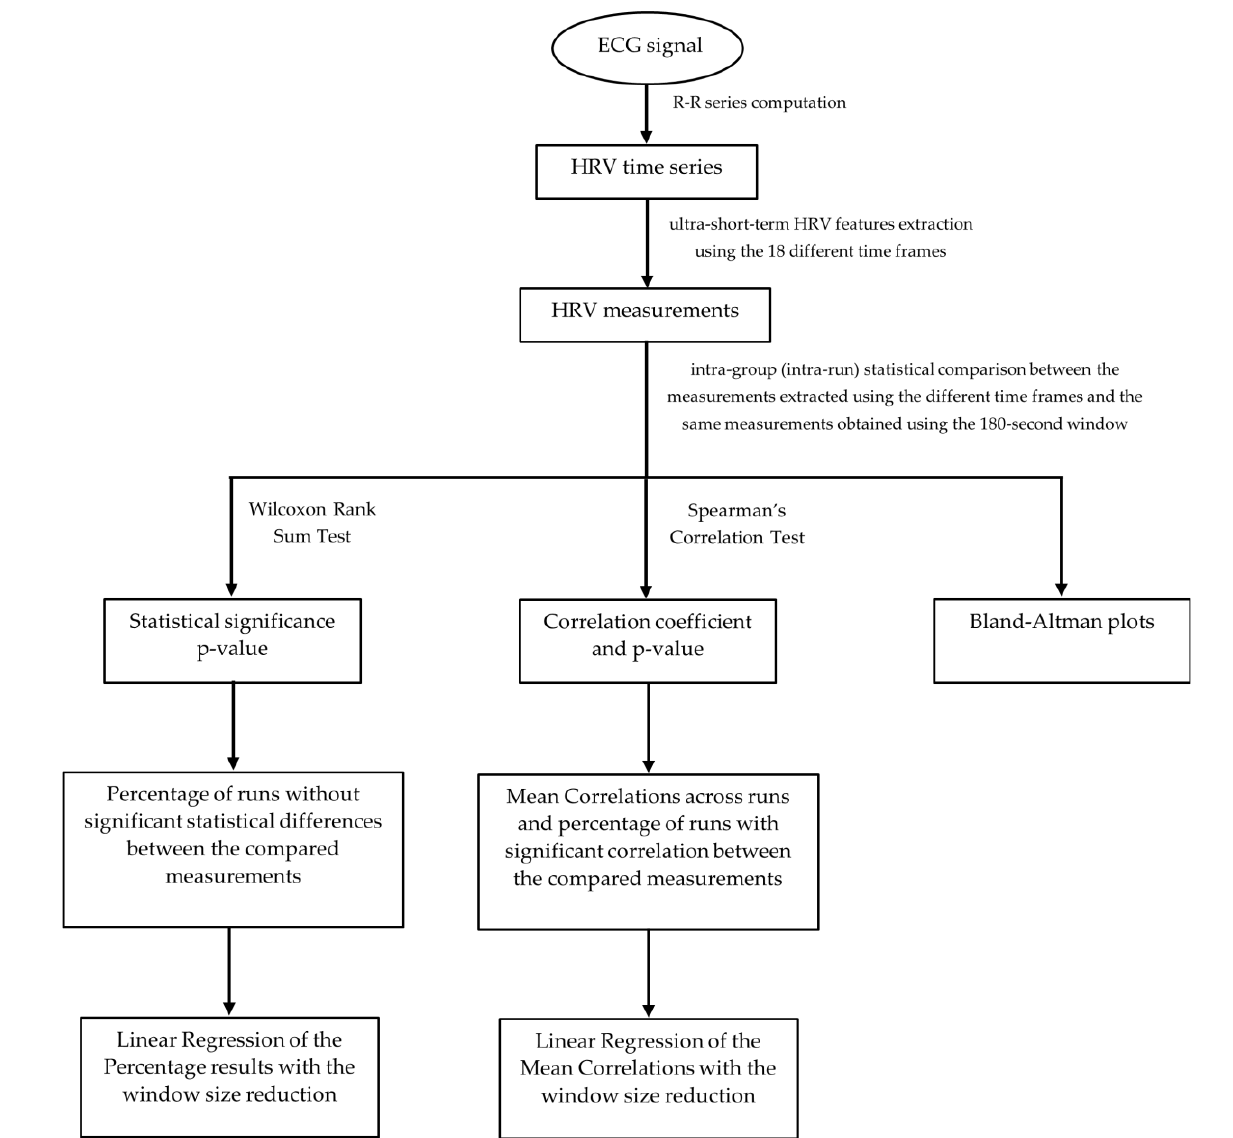
Figure 4. General Flow Chart of the experimental steps followed to evaluate the ultra-short-term HRV measurements’ reliability .